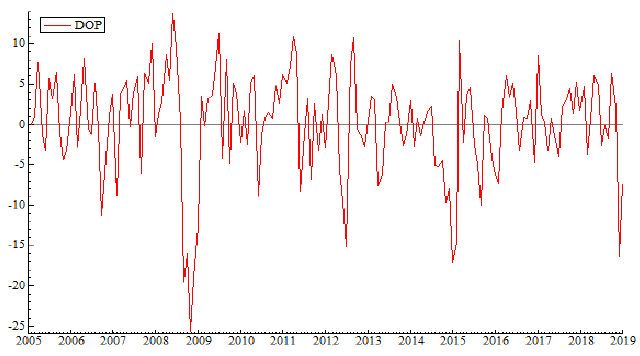
Figure 2. Stock price returns and Brent oil price changes: January 2005 – December 2018.